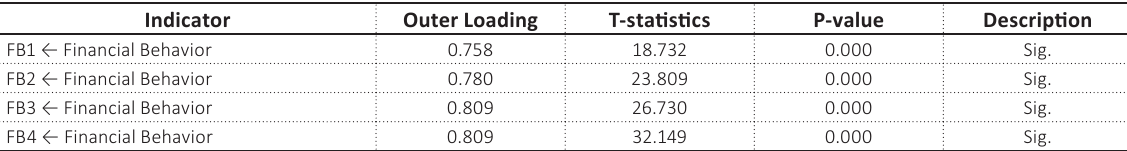
Source: Own elaboration using PLS.